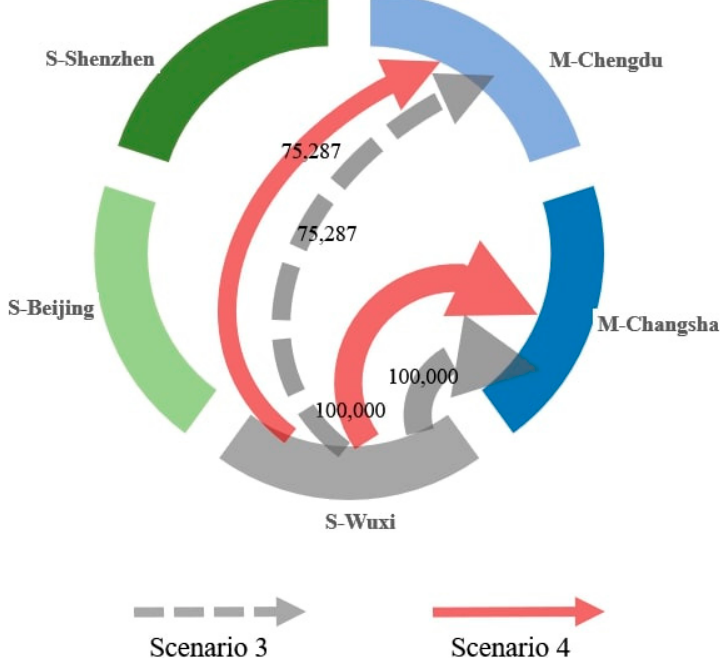
Figure 5. The solutions for Scenarios 3 and 4.